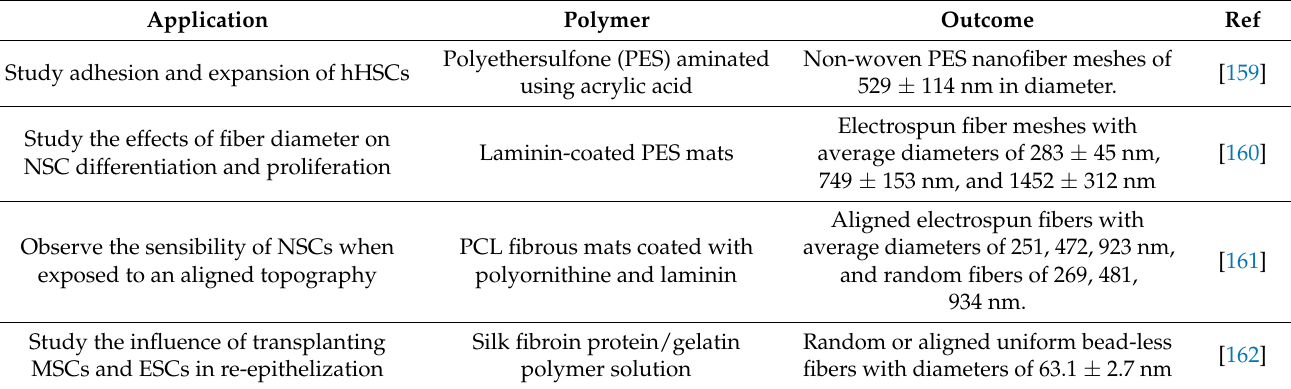
Table 5. Summary of electrospun constructs used to recreate the micro and nano spatial cues of the stem cell niche.